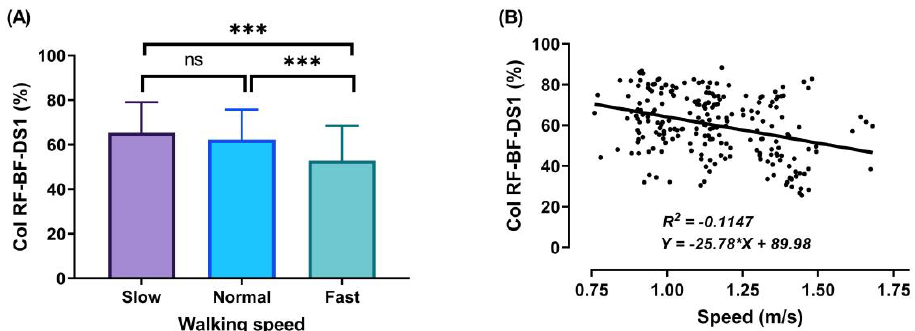
Figure 6. Mean of thigh muscles (RF-BF) co-activation at different walking speeds (slow, normal, and fast) during walking phases: DS1 ( A ). ANOVA results showing the effects of changing in CoI of thigh muscles during walking speed (slow, normal, and fast). Correlation between walking speed and thigh muscles (RF-BF) co-activation during DS1 walking phase ( B ). Asterisk signs above the line represent significant differences between walking speed: (***) indicates p ˂ 0.001, and (ns) indicates non-significant.